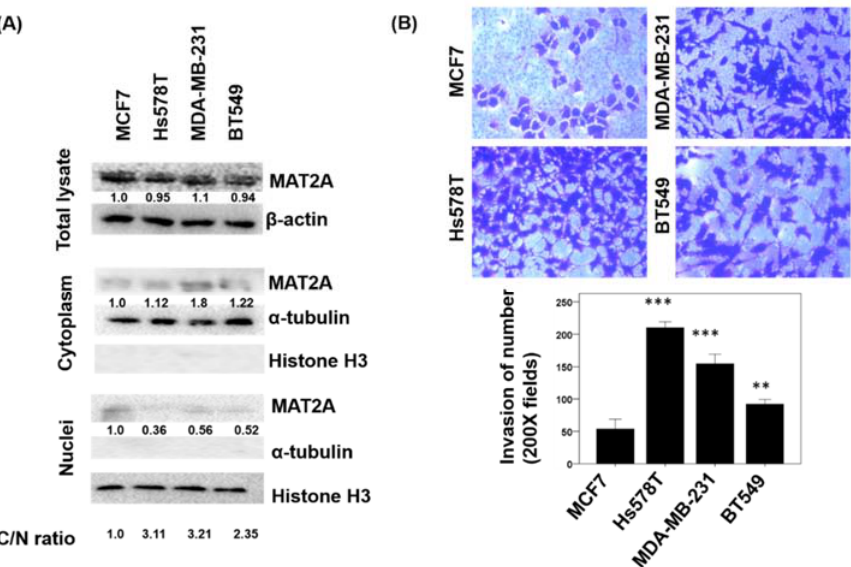
Figure 5. Cellular protein expression pattern of MAT2A, and the invasiveness were investigated in a panel of breast cancer cell lines. ( A ) Cytoplasmic and nuclear protein lysates were prepared from the MCF7, Hs578T, MDA-MB-231, and BT549 breast cancer cell lines and protein expression levels were analyzed by Western blotting using specific antibodies against MAT2A, β -actin, α -tubulin, and Histone H3. ( B ) Invasion assay in MCF7, Hs578T, MDA-MB-231, and BT549 breast cancer cell lines. C/N ratio: cytoplasm to nucleus ratio. The histogram represents means ± SEs from three independent experiments (**, p < 0.01; ***, p <